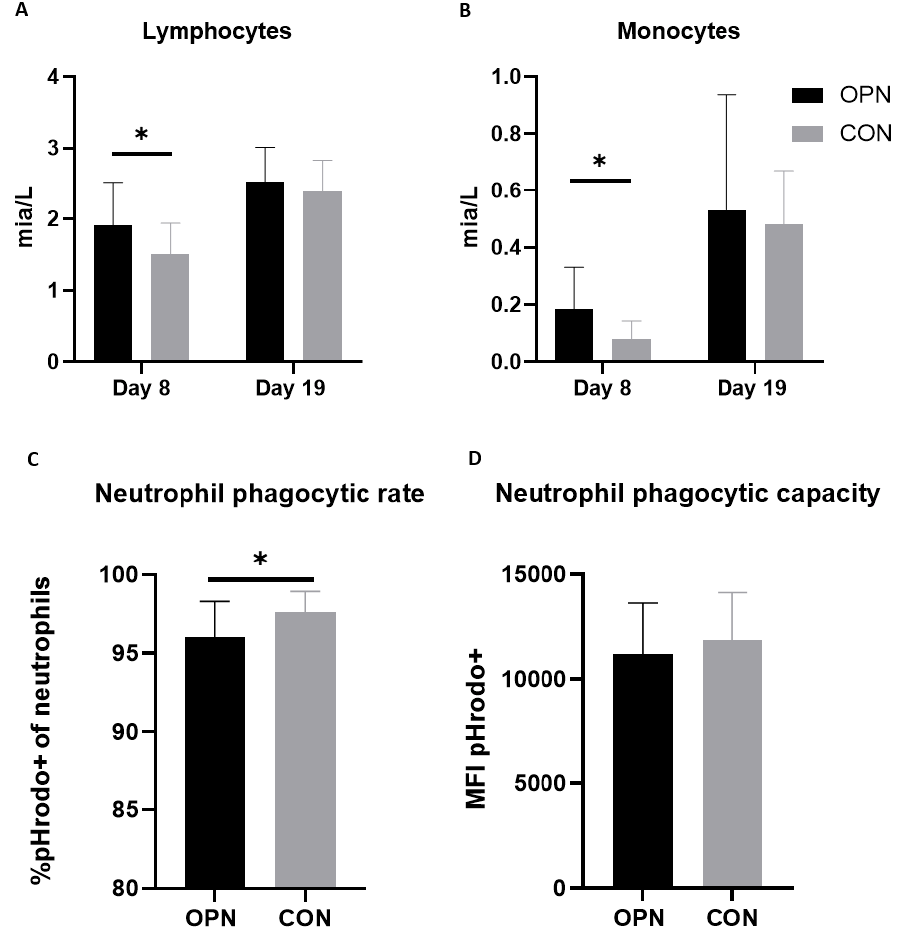
Figure 5. Full blood lymphocyte ( A ) and monocyte ( B ) counts in preterm pigs on Days 8 and 19. The pigs received a bovine milk diet (CON, n = 12–18) or the milk diet supplemented with bovine milk osteopontin (OPN, n = 9–14). Neutrophil phagocytic rate ( C ) and capacity ( D ) on Day 19 of OPN and CON pigs. Data are expressed as mean ± SD. * p < 0.05. MFI, mean fluorescent intensity.